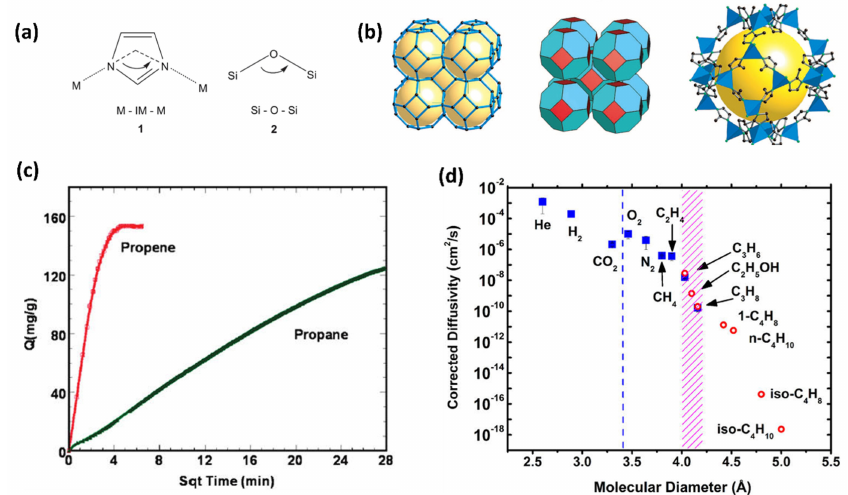
Figure 2. ( a ) The bridging angles in ZIFs (1) and zeolites (2) [47]. ( b ) SOD topology and structure of ZIF-8 [47]. ( c ) Propylene and propane kinetic uptake by ZIF-8 [51]. ( d ) Corrected diffusivities in ZIF-8 at 35 ◦ C versus molecular diameter of probe molecules